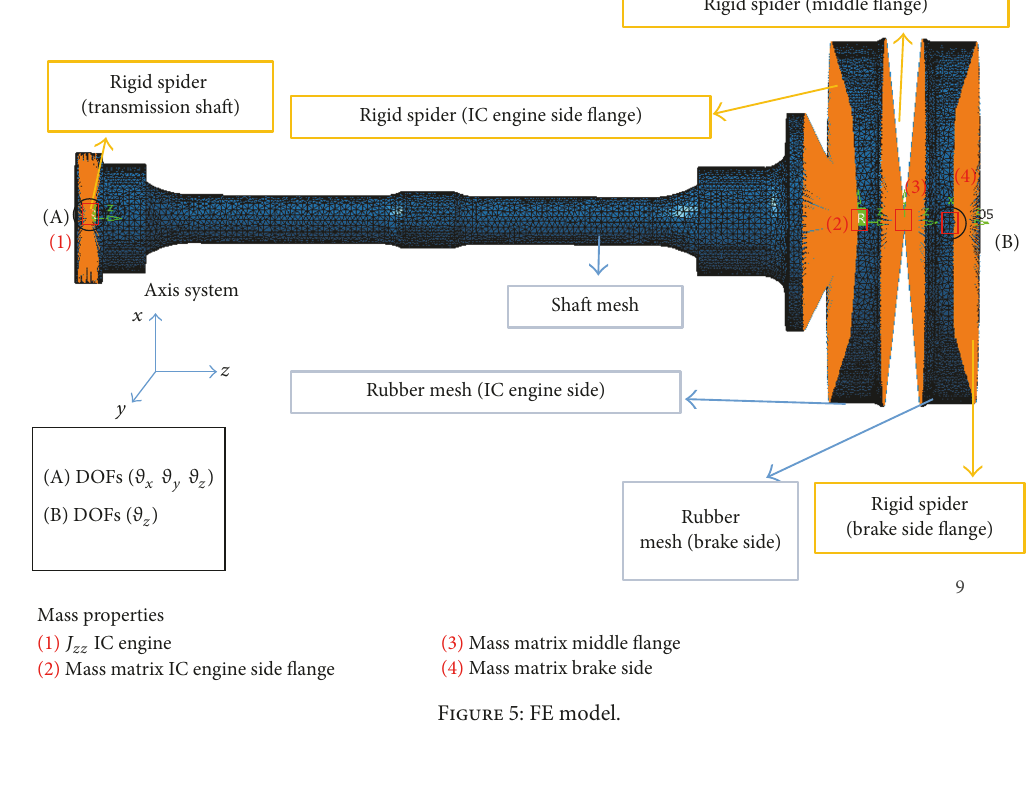
Table 1: 3D mesh